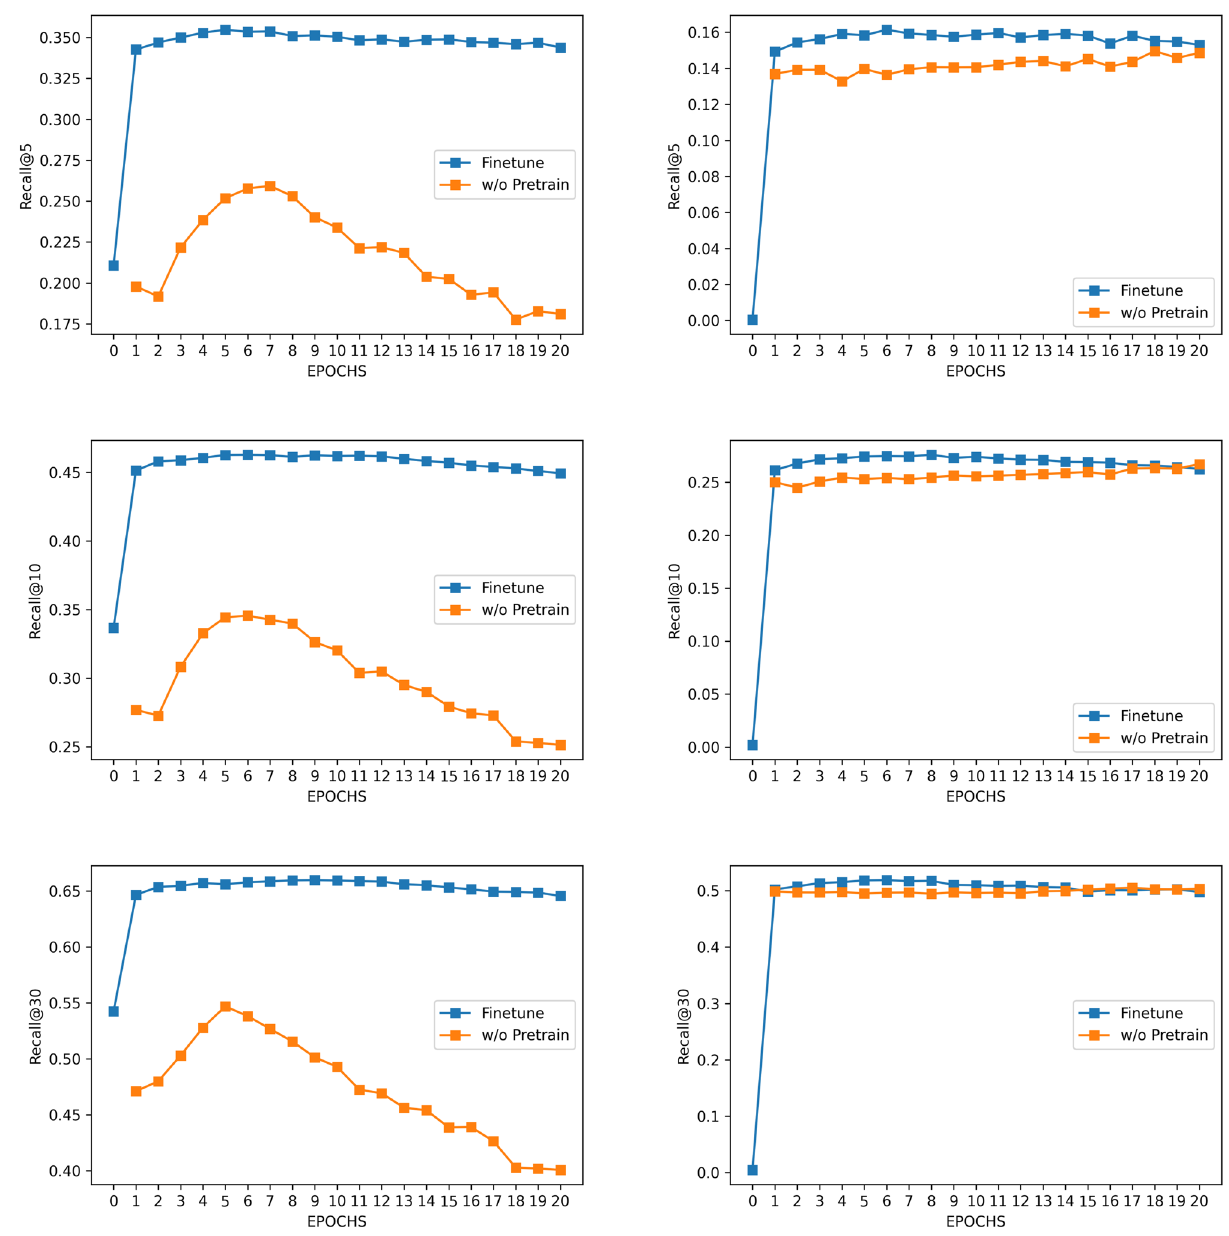
Figure 10. The impact of pre-training on improving the performance on PFK-2013 (left) and MIMIC-3 (right), PFK-2013 is a subset of the PFK pediatric claims dataset (not used in the pre-training phase), while MIMIC-3 contains ICU patient records. The pre-training procedure results in less than 5% in the model performance for MIMIC-3, but more than 10% improvement for